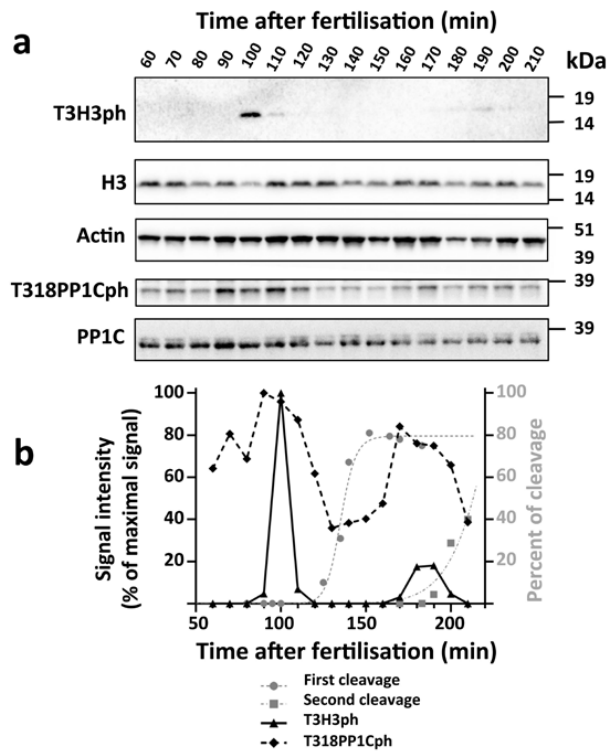
Figure 1. A peak of T3H3 phosphorylation precedes cell cleavage in S. granularis early embryos. ( a ) Western blots showing the relative levels of T3H3ph, H3, Actin, T318PP1Cph and PP1C at different times during the first and second embryonic divisions. ( b ) Quantitative analysis of the above results. For each lane, the T3H3ph (black triangles) and T318PP1Cph (black diamonds) intensity scores were normalised against the amount of Actin signal detected. The values obtained were expressed as a percentage of the maximal signal observed. The graph includes as a visual reference the proportion of embryos that have completed either the first cleavage (grey dots) or the second cleavage (grey squares) at different time points.